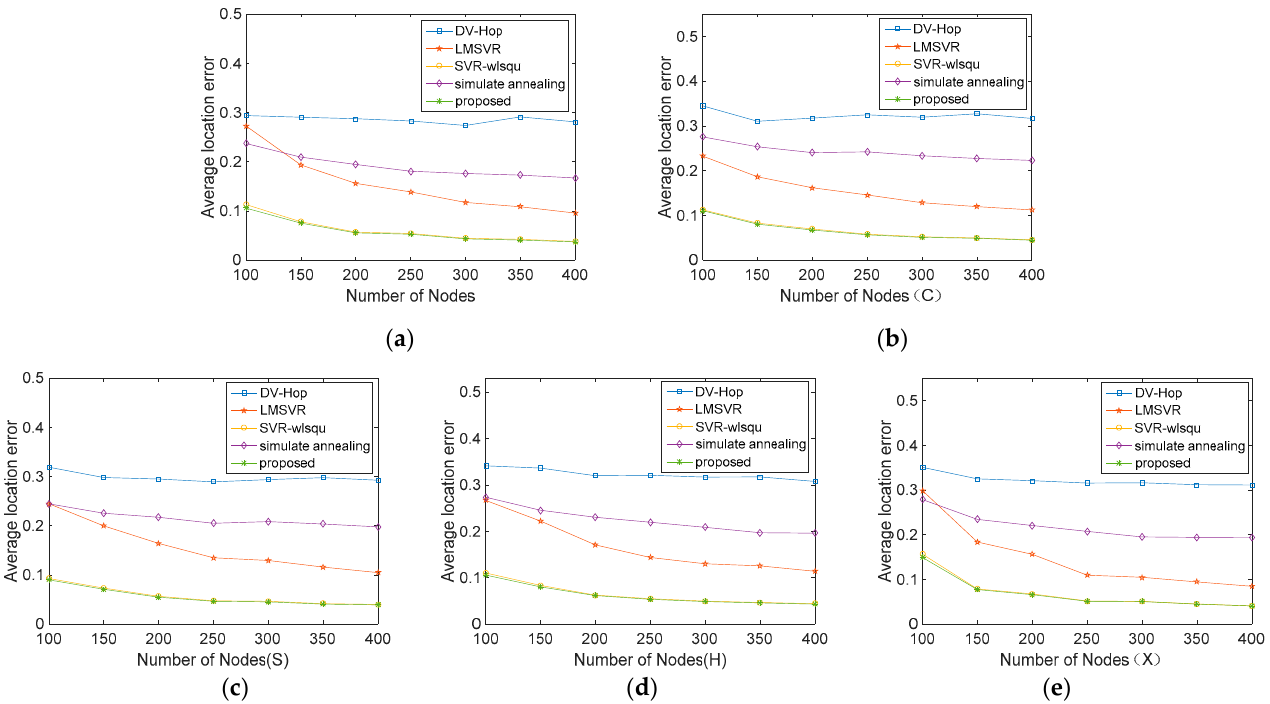
Figure 5. Comparison of the average location error under various total number of nodes. ( a ) isotropic networks. ( b ) C-shape network. ( c ) S-shape network. ( d ) H-shape network. ( e ) X-shape network.